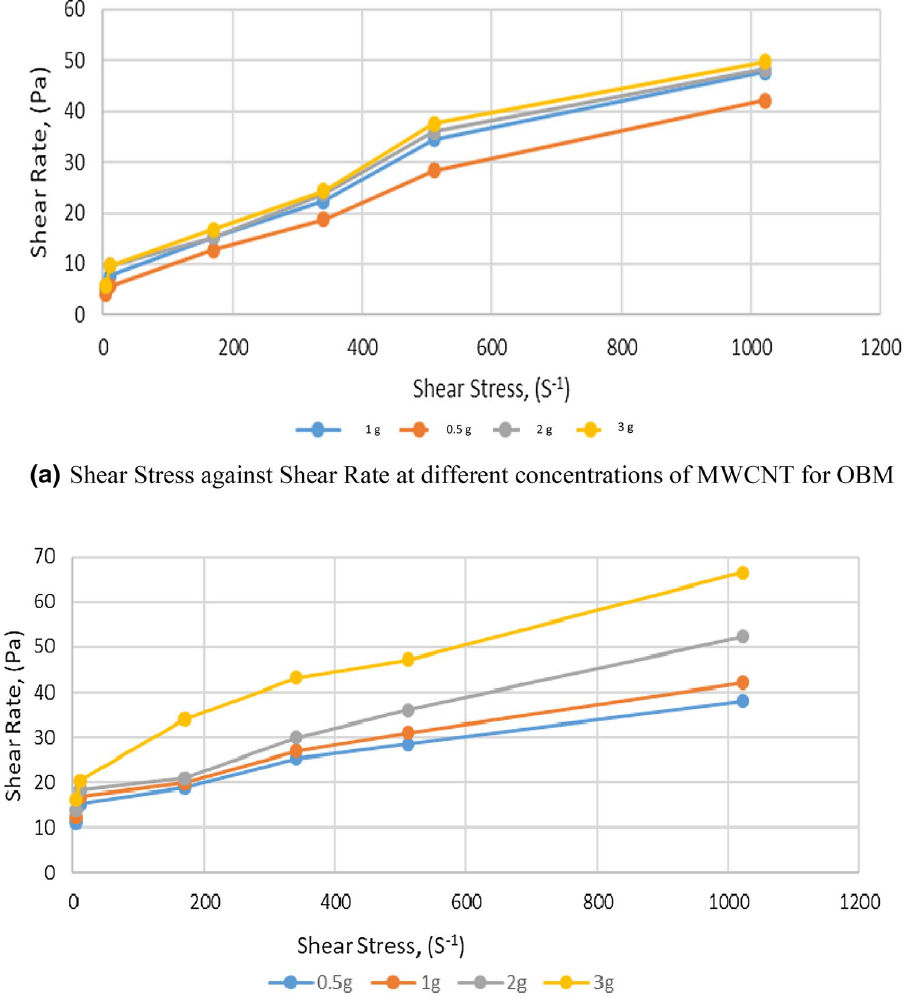
Fig. 1 a Shear stress against shear rate at different concentra- tions of MWCNT for OBM. b Shear stress against shear rate at different concentrations of MWCNT for